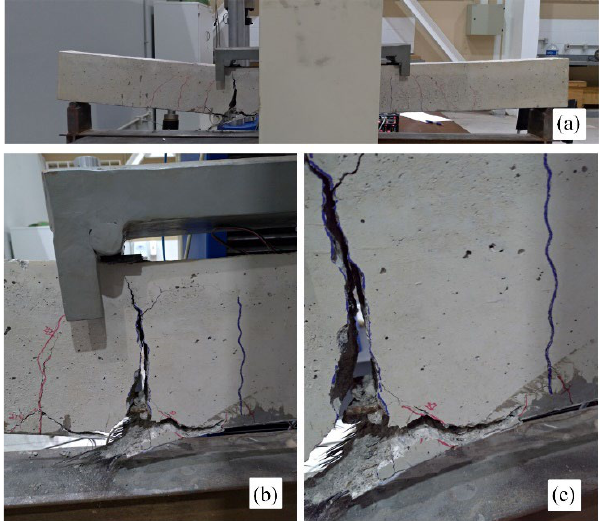
Figure 17. Failure of specimen CR50-NI (a); Detail of the specimen’s failure location (b); Detail of the rupture of the CFRP sheet and positive reinforcement (c).